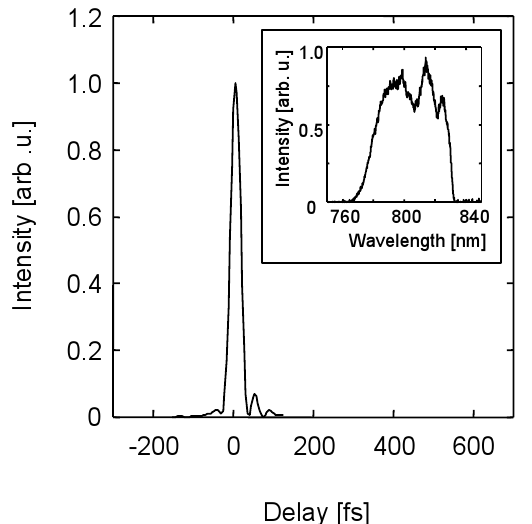
Figure 9. Recompressed pulse. Insert: spectrum.